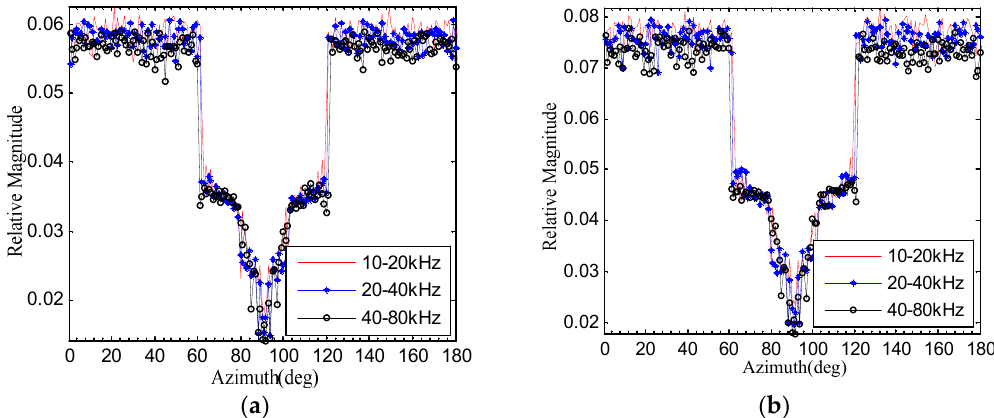
Figure 4. ( a ) Fluctuation intensity comparison of a synthetic echo envelope with different frequencies; ( b ) STD comparison of synthetic echo envelope fluctuation intensity with different frequencies.